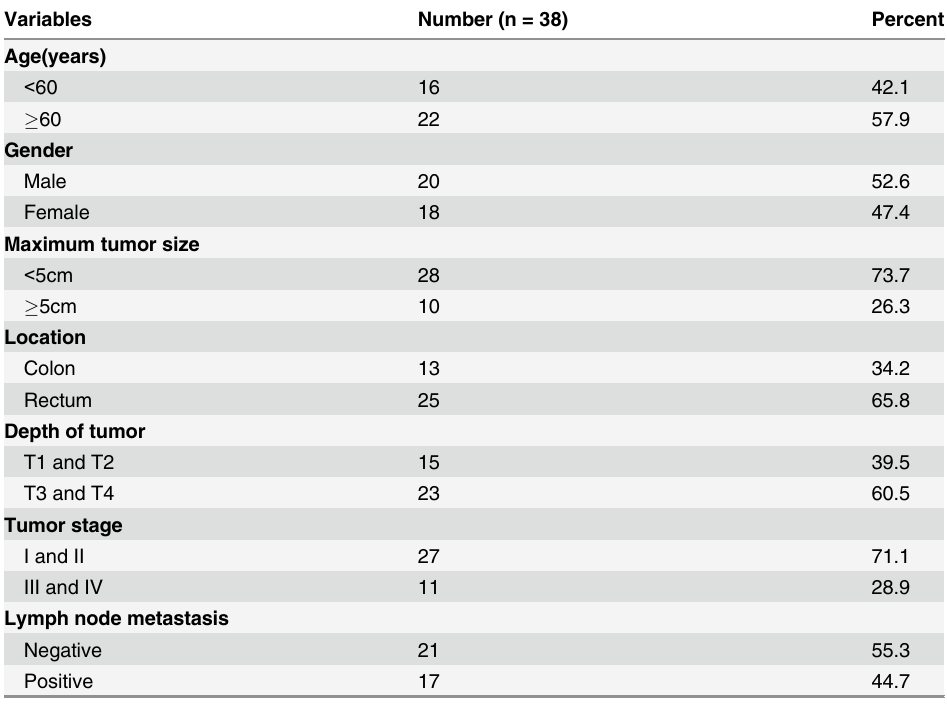
Table 1. The Clinical Characteristics of the CRC